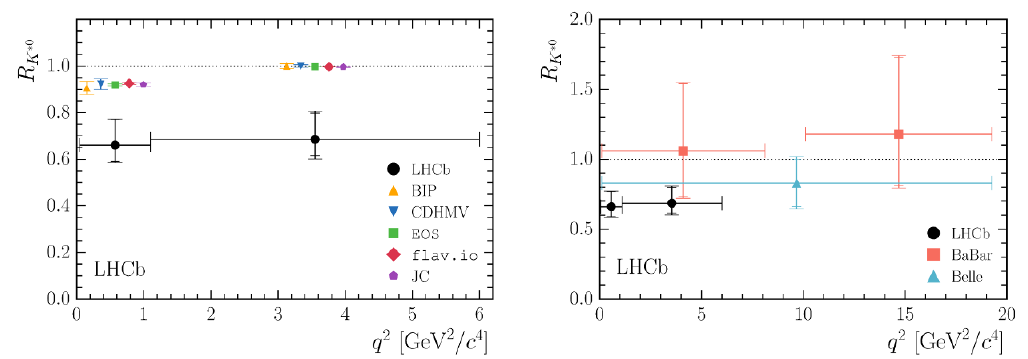
Figure 10 . (Left) Comparison of the LHCb R measurements with the SM theoretical predic- K (cid:3) 0 tions: BIP [26] CDHMV [27{29], EOS [30{32], flav.io [33{35] and JC [36]. The predictions are displaced horizontally for presentation. (right) Comparison of the LHCb R measurements with K (cid:3) 0 previous experimental results from the B factories [4, 5]. In the case of the B factories the speci(cid:12)c vetoes for charmonium resonances are not